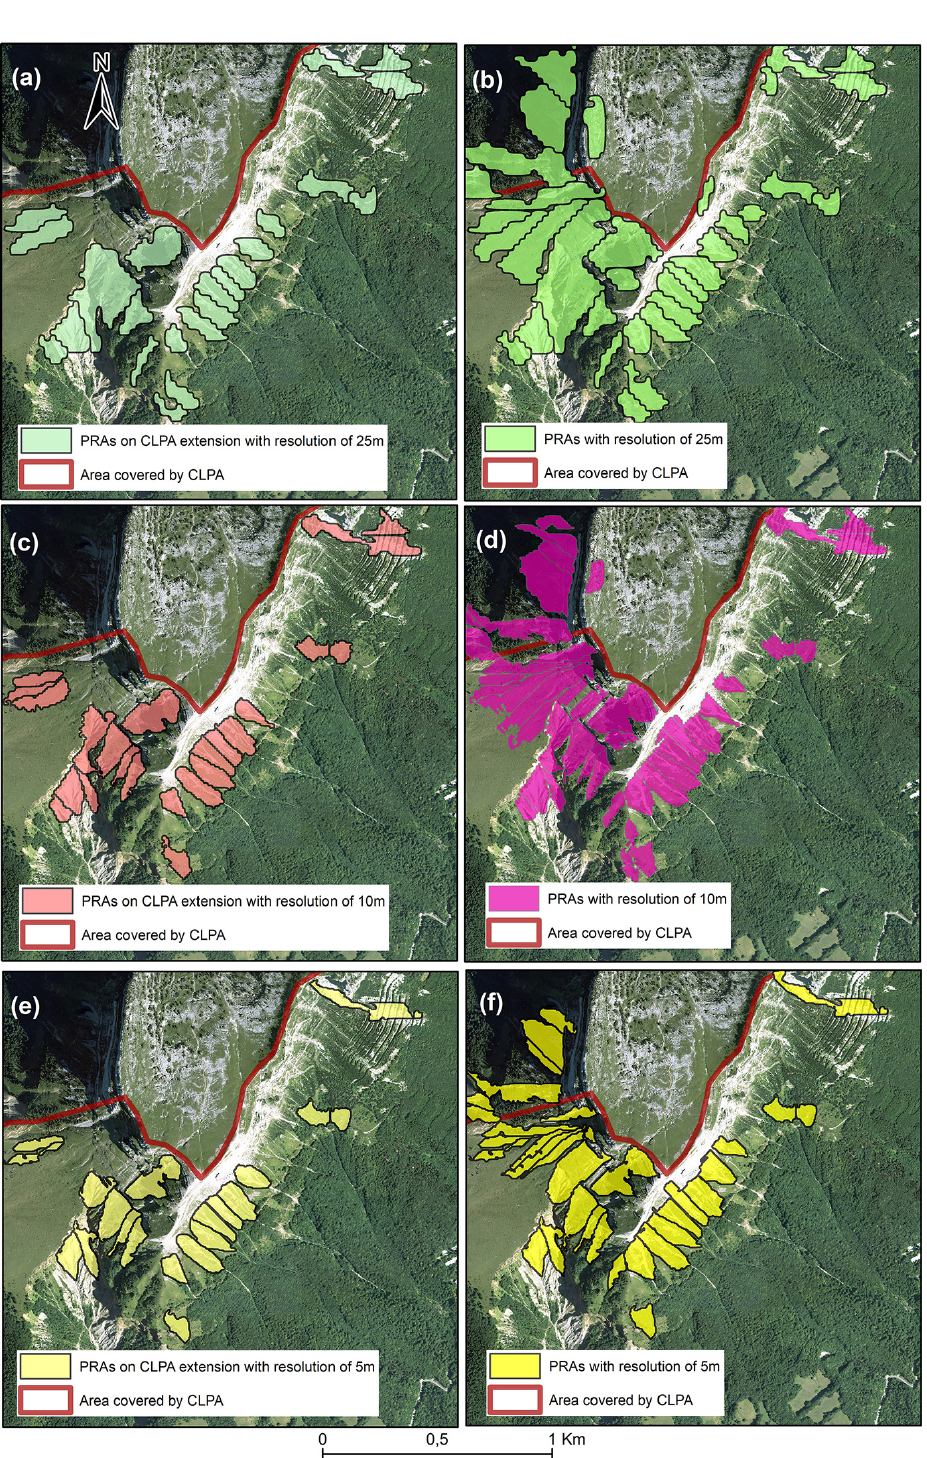
Figure 12. Combined effect of DEM resolution on the selection of the validation sample (a, c, e) and PRA detection (b, d, f) , Chartreuse/Dent de Crolles study area. For the PRA detection and the determination of the validation sample, DEM resolution varies, all other factors are set to their default values (Figs. 3–4), and forest cover data are from DB forest IGN. Aerial photograph © IGN 2012. In (a) , (c) , and (e) , the absence of CLPA in the upper-left corner is clearly visible, and “CLPA extension” refers to avalanche extents from the French avalanche